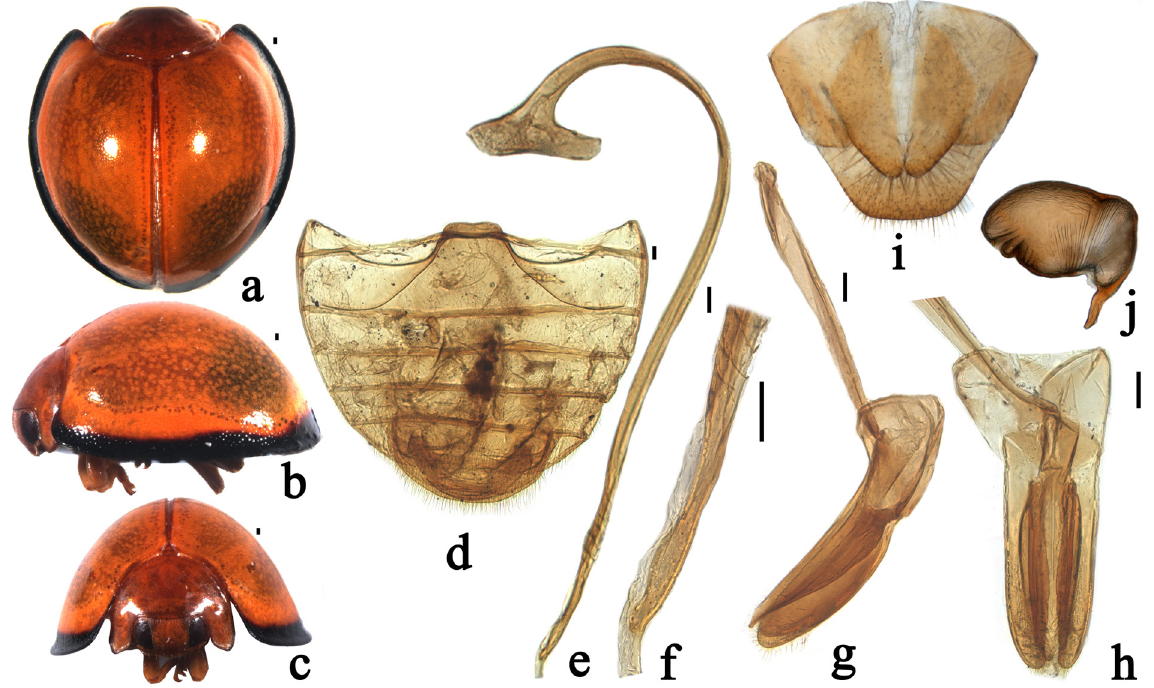
Fig. 10. Chilocorus circumdatus (Gyllenhal, 1808). a . Dorsal view. b . Lateral view. c . Frontal view. d . Abdomen. e . Penis. f . Apex of penis. g . Tegmen, lateral view. h . Tegmen, ventral view. i–j . Female genitalia. i . Ovipositor. j . Spermatheca. Scale bars: 0.1